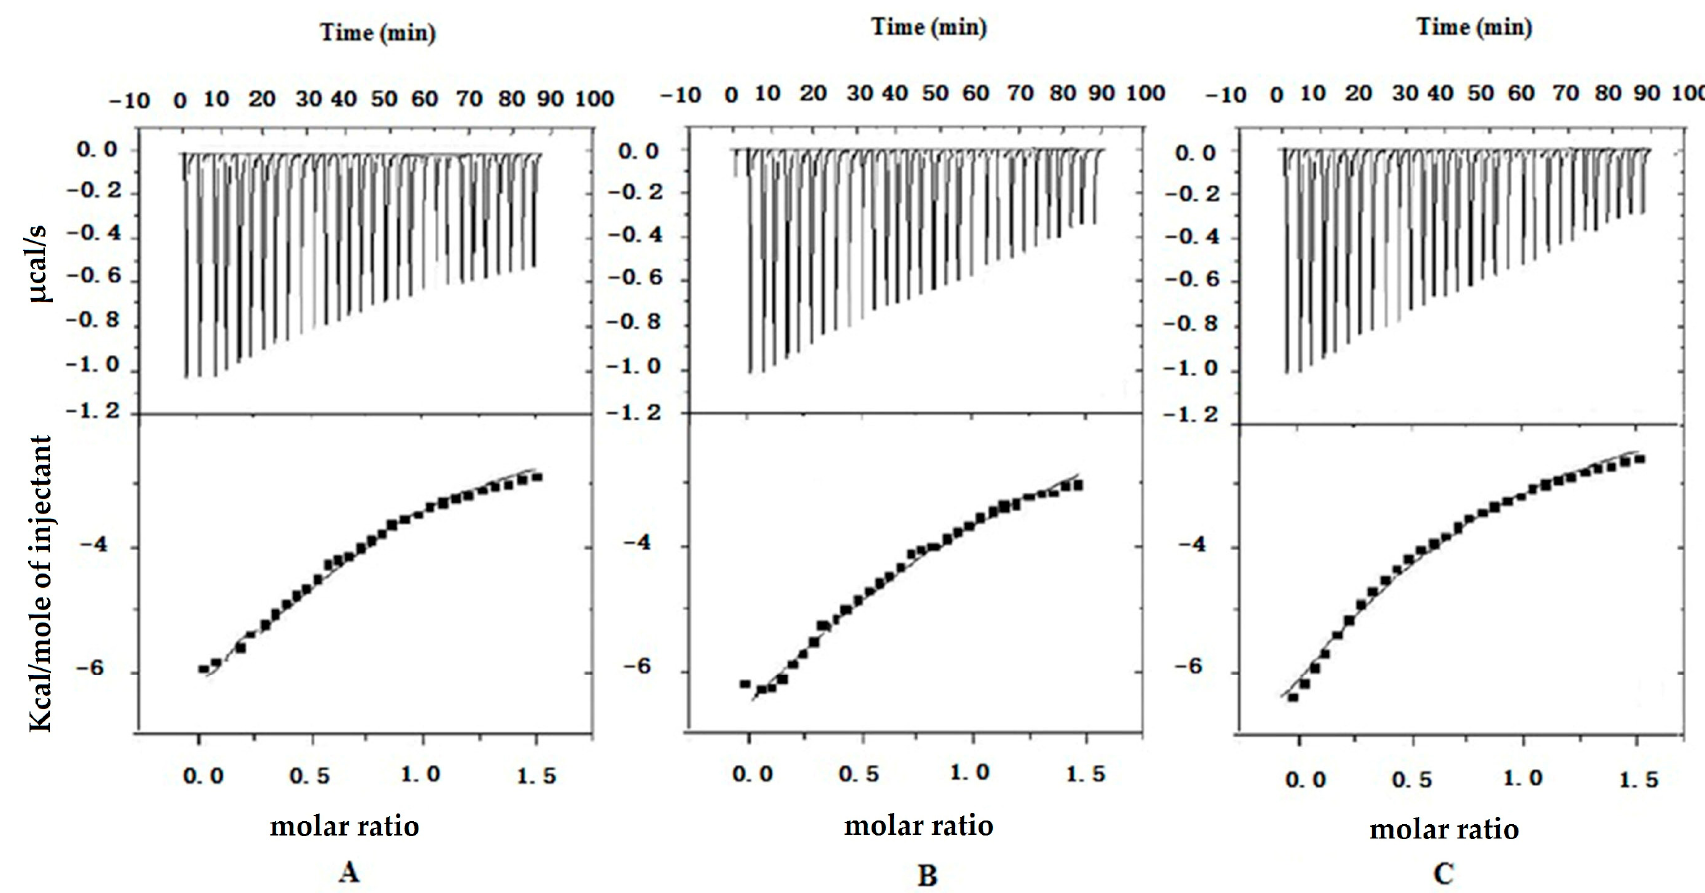
Figure 3. ITC data from the titration of R8 ( A ); R6EW ( B ) and SAR6EW ( C ) in the presence of insulin. In the top panel, the peaks indicate the heat released after each addition. The peaks were integrated and the total heat released per injection (peak area) is plotted as a function of molar ratio in the bottom panel.